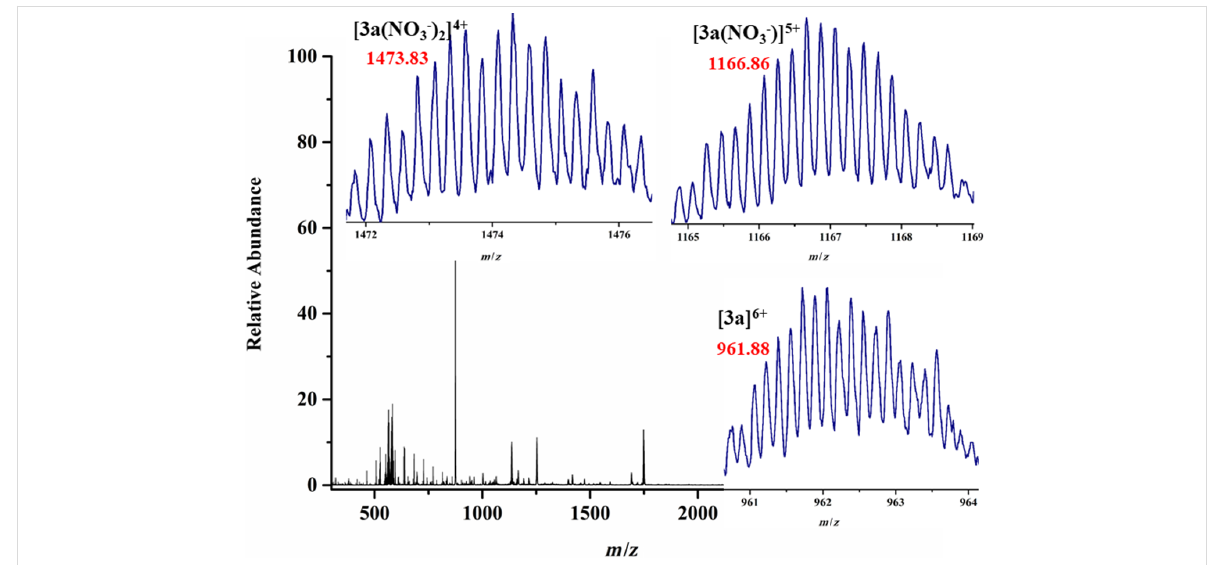
Figure 3: ESIMS spectrum of 3a in methanol. Inset: experimentally observed isotopic distribution patterns of the charged fragments.